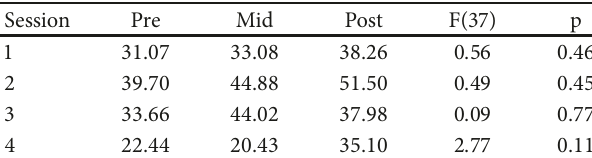
Table 1: SSQ total scores.